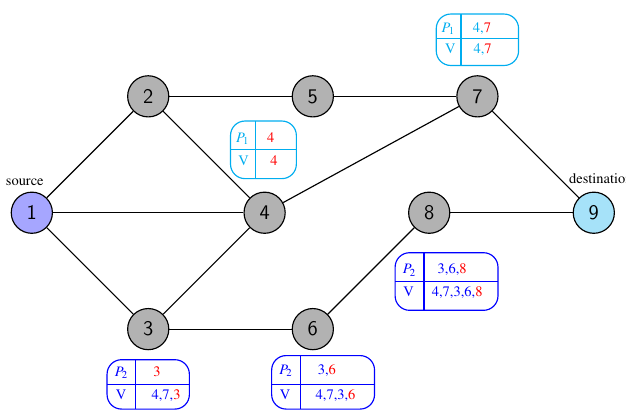
Figure 1. Routing across disjoint paths: the case of 2 disjoint paths.